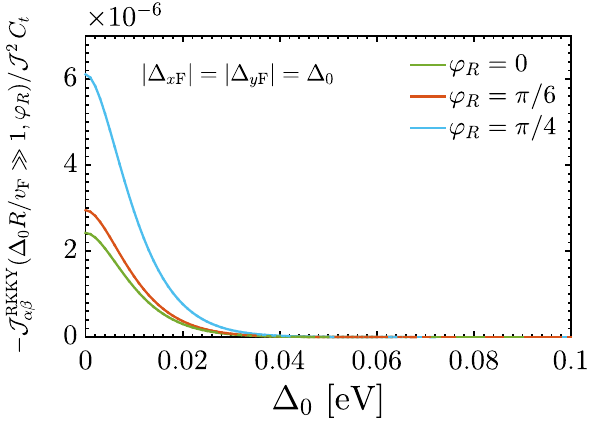
Figure 14. Long-range behavior of the RKKY interaction (cid:31) 0 at fixed long-range impurity separation R